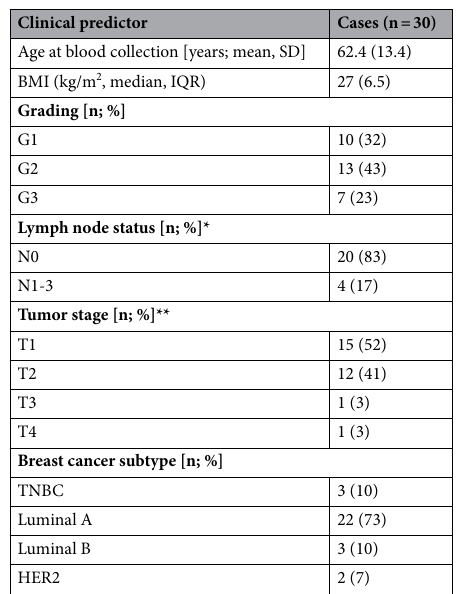
Table 1. Patient characteristics of breast cancer cases showing means and standard deviations (SD) for continuous characteristics and frequencies and percentages for categorical characteristics. BMI Body mass index; IQR Interquartile range; TNBC Triple-negative breast cancer; SD standard deviation. *data only available for 24 patients ** data only available for 29 patients.